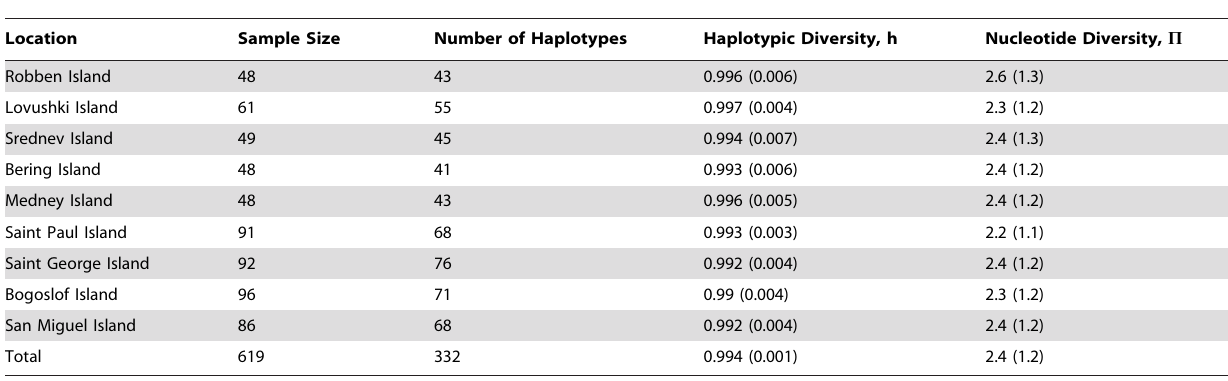
Table 2. Summary of mtDNA diversity in 9 populations of Northern fur seal.